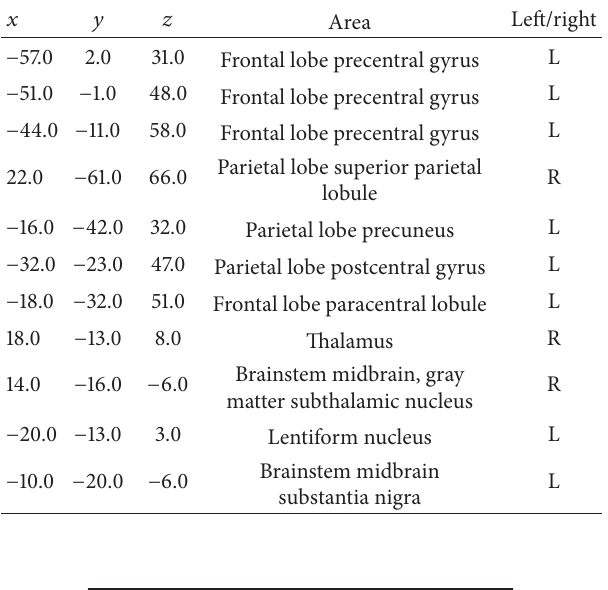
Table 4: Coordinates of Talairach’s Atlas ( 𝑥/𝑦/𝑧 axis) resulting from hypometabolic contrast SPM- 𝑡 analysis of autoimmune inner ear disease group versus control